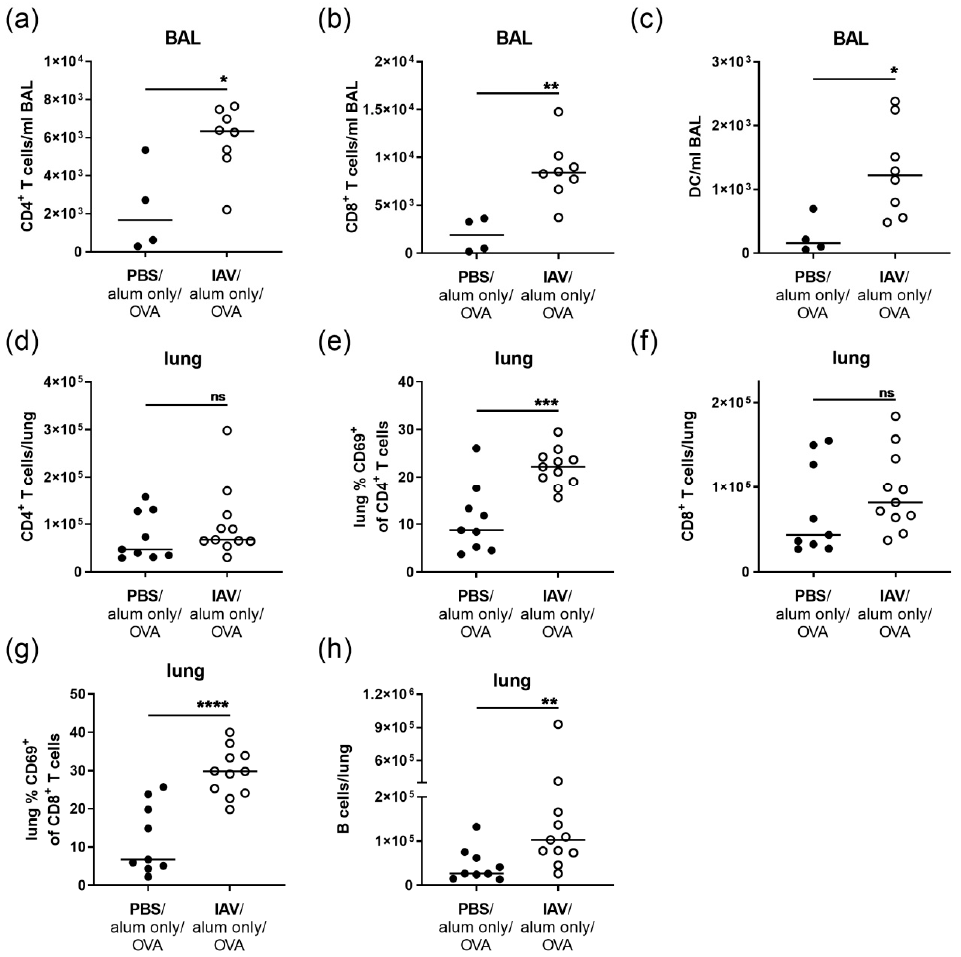
Figure 2. Resolved IAV infection leads to elevated T cell numbers in the BAL and to persistent T cell activation as well as accumulation of B cells in the lung. Mice were infected i.n. with a sublethal dose of IAV or treated with PBS on day 0, were mock-sensitized (alum only i.p.; days 14, 21, 28) and treated i.n. with OVA (days 35, 36, 37). On day 39 post infection, CD4 + T cell ( a ), CD8 + T cell ( b ) and DC ( c ) numbers in the BAL (bronchoalveolar lavage) were flow cytometrically analyzed. In the lung, CD4 + T cell numbers ( d ), CD69-expression of CD4 + T cells ( e ), CD8 + T cell numbers ( f ), CD69-expression of CD8 + T cells ( g ) and B cell numbers ( h ) were analyzed. Data are shown for individual mice together with the group median. BAL data are compiled from at least two independent experiments and lung data are compiled from three independent experiments. * p < 0.05, ** p < 0.01, *** p < 0.005, **** p < 0.001, ns = not significant.